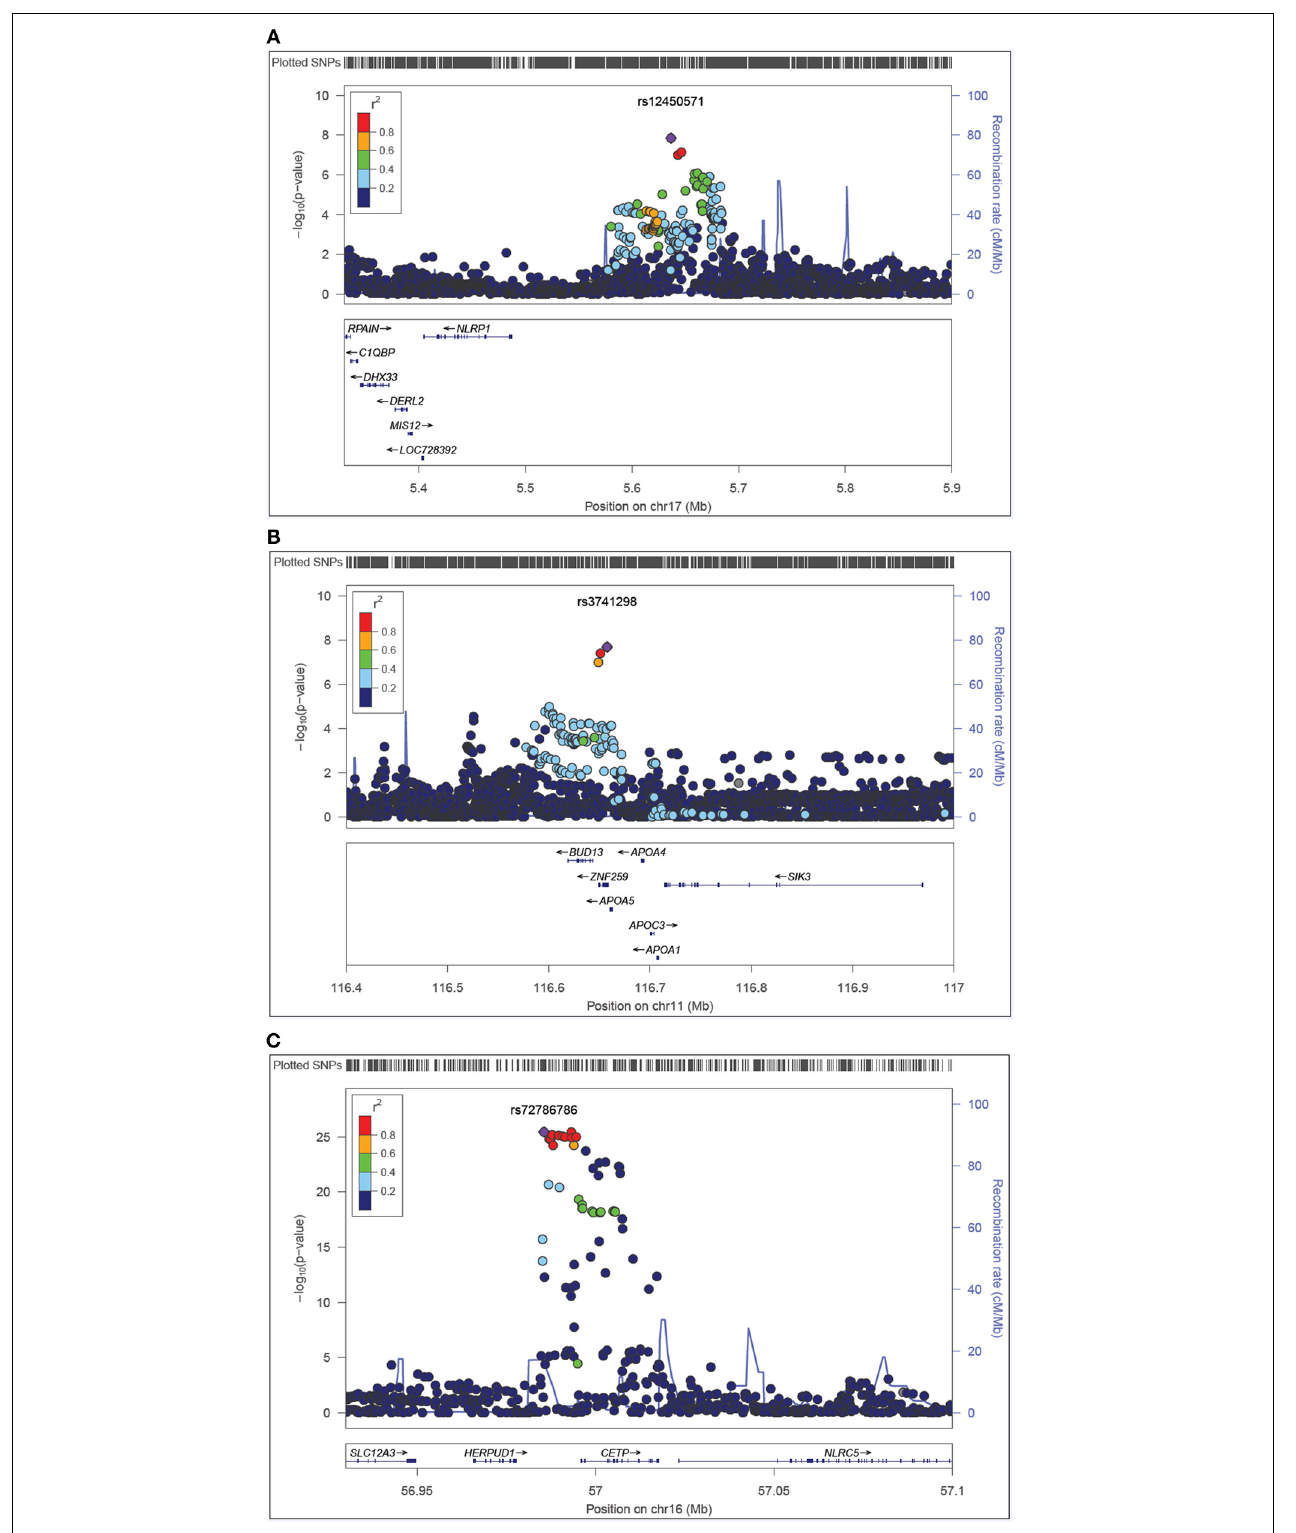
FIGURE 1 | Regional plots represent the associations between plasma levels of HDL and NLRP1 (A), ZNF259 (B), and CEPT (C) gene regions. The − log 10 ( p - value) for HDL is represented in the ordinate axis, while the chromosome position in Megabase (Mb) using build 37.3 is represented in the abscissa axis. The bottom panels give the relative